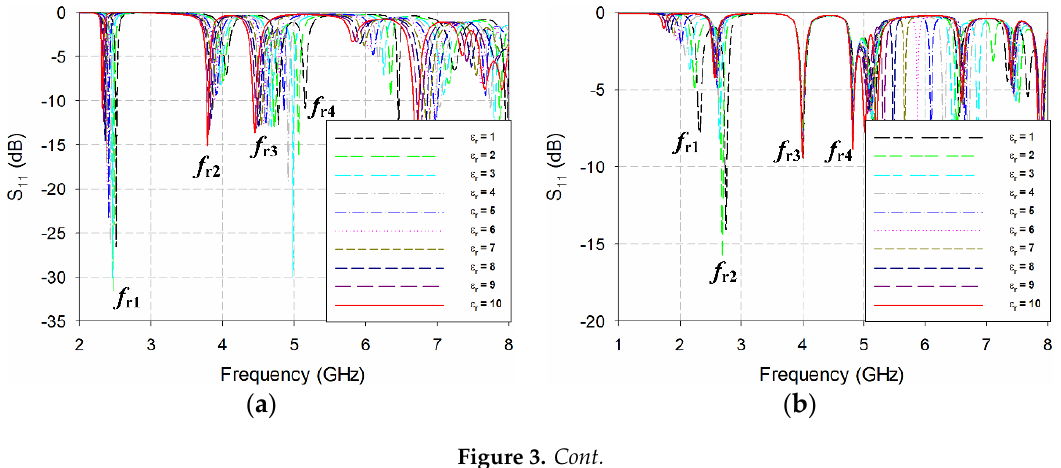
Figure 3. S 11 characteristics when varying the relative permittivity of the MUT from 1 to 10 for: ( a ) the 187 conventional MPSA without a DGS; ( b ) the RS DGS-loaded MPSA; ( c ) the SR-CSRR-OS DGS-loaded 188 MPSA; ( d ) the SR-CSRR-IS DGS-loaded MPSA; ( e ) the R-SR-CSRR DGS-loaded MPSA; ( f ) the DR-